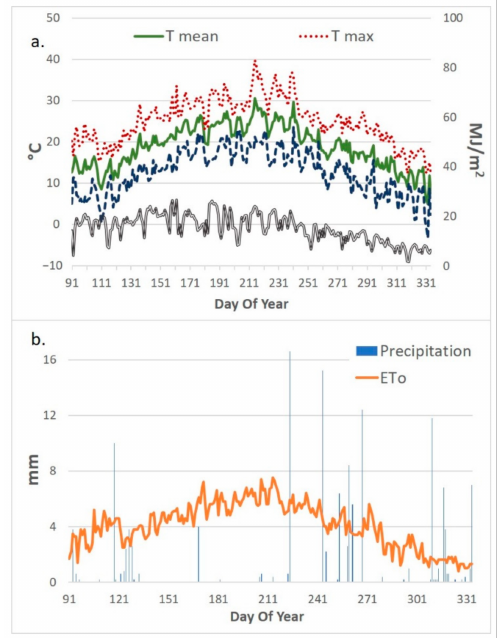
Figure 3. Climatic data for Grosseto2018. ( a ) temperature and daily solar radiation; ( b ) precipitation and reference evapotranspiration. Data provided by Consorzio Lamma, Laboratory for Meteorology and Environmental